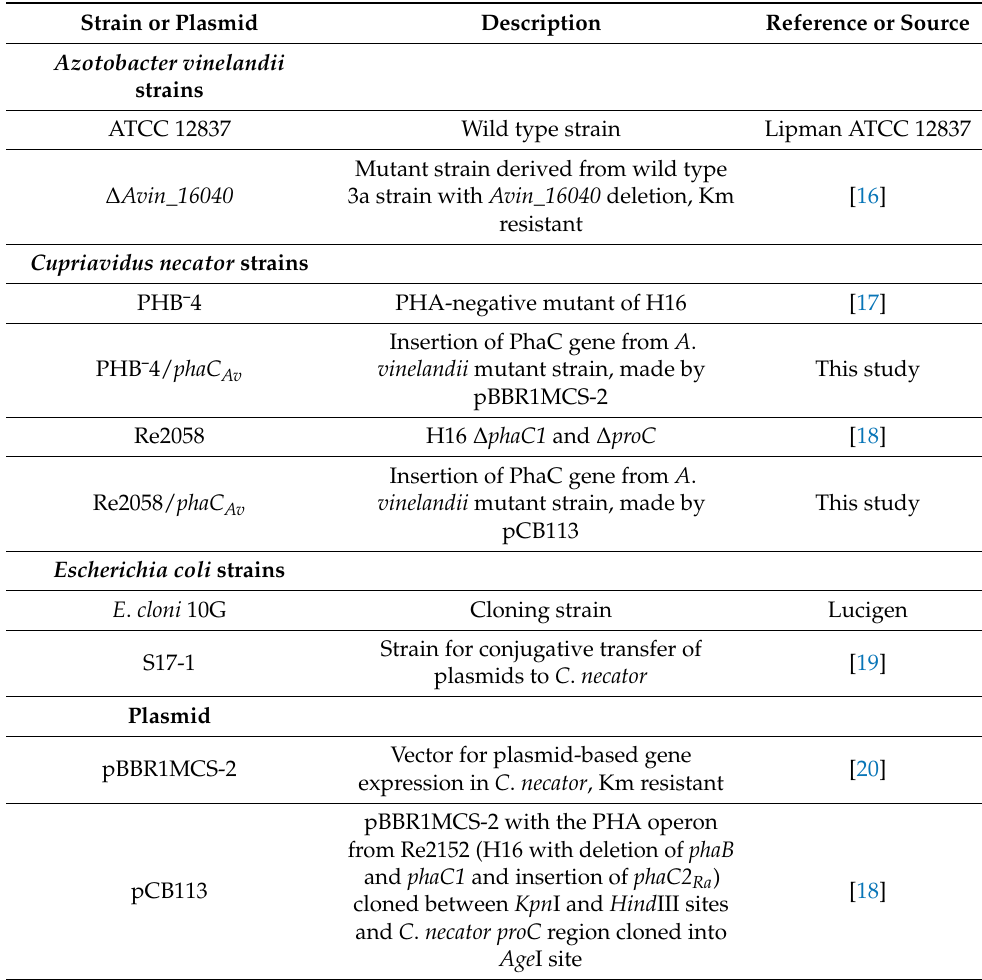
Table 1. Strains and plasmids used in this